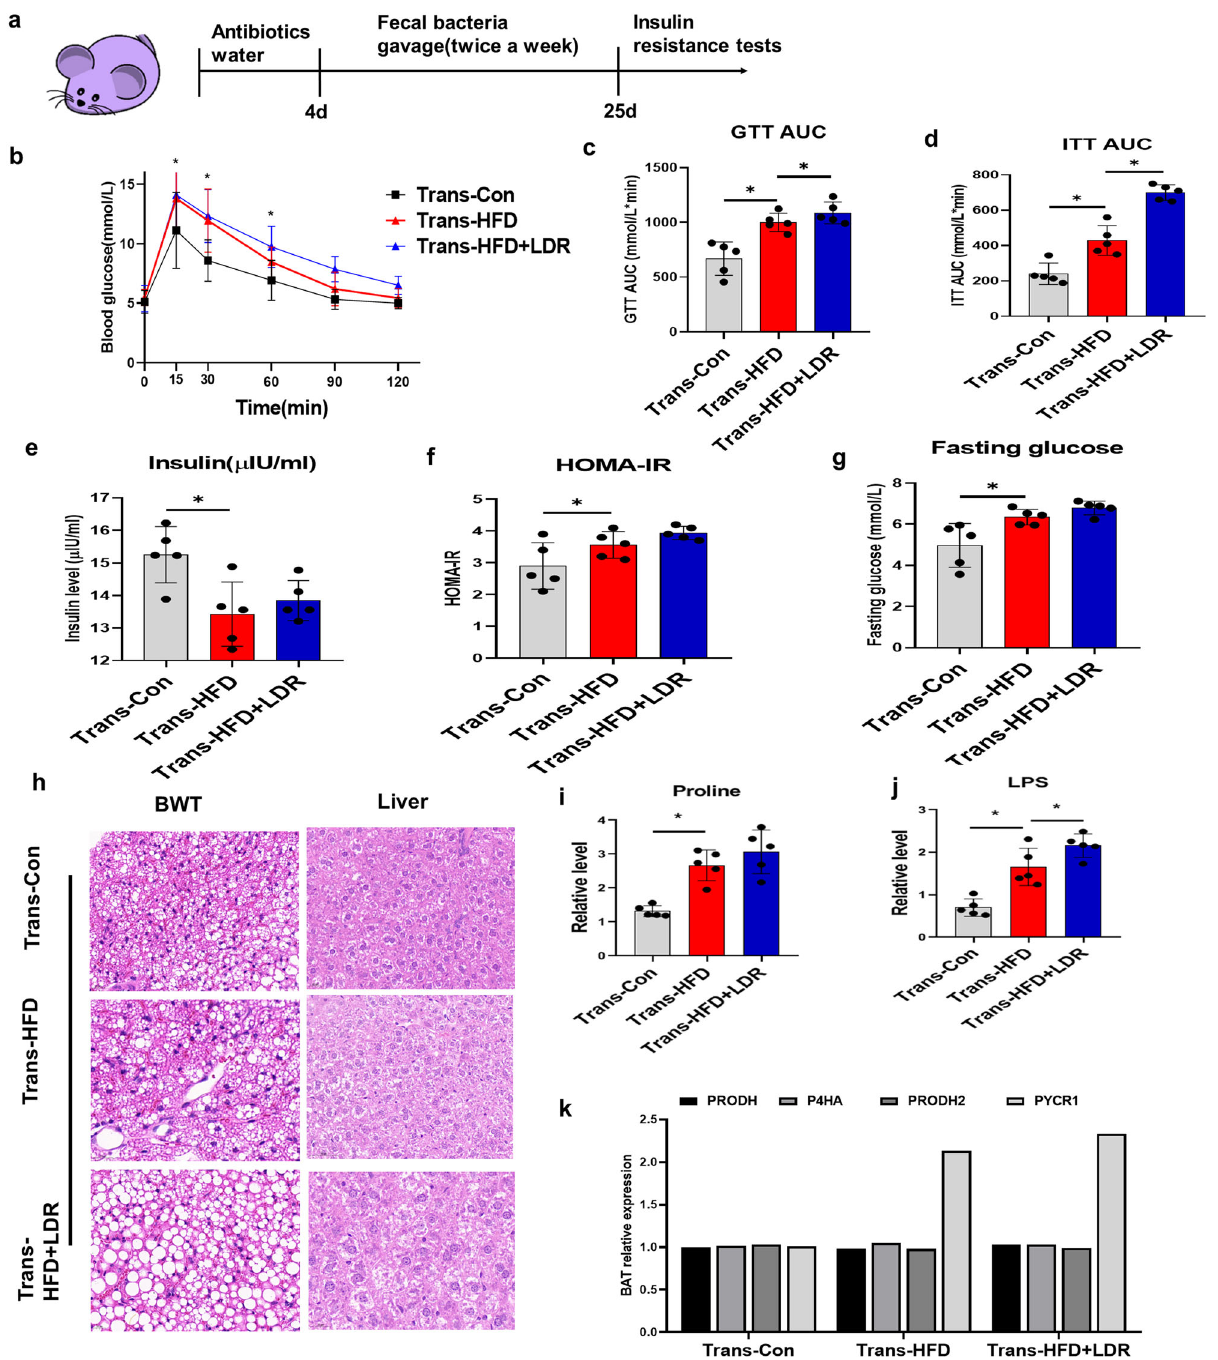
Fig. 5 FMT with microbiotas from HFD and LDR + HFD mice disrupts insulin sensitivity, PA metabolism and PYCR1 expression. The mice transplanted with stool suspensions from healthy controls, HFD cases and LDR + HFD cases were de fi ned as Trans-Con, Trans-HFD and Trans-LDR + HFD mice, respectively. After treatment with antibiotics in drinking water for 4 days, the mice were gavaged with stool suspensions twice per week. a Timeline for treatment of the mice with faecal bacteria via gavage after antibiotic-mediated depletion of the gut microbiota. b Glucose levels ( n = 5 per group). c GTT AUC values ( n = 5 per group). d ITT AUC values ( n = 5 per group). e Insulin levels ( n = 5 per group). f HOMA-IR values ( n = 5 per group). g Fasting glucose values ( n = 5 per group). h H&E staining of representative BAT and liver tissues (40X). i Relative levels of PA ( n = 5 per group). j LPS levels ( n = 5 per group). k Relative expression of PRODH, P4HA, PRODH2 and PYCR1 for the Trans-Con, Trans-HFD and Trans-LDR + HFD groups. The data are the means±SDs. The Mann-Whitney test or two-tailed unpaired Student ’ s t -test was used for statistical analyses. * p <0.05 indicates a signi fi cant difference. Error bars indicate SEM (standard error of the mean). a was created by Ruixue Huang and the elements used was permitted by Biorender (https://biorender.com/) because Ruixue Huang is one of the registered